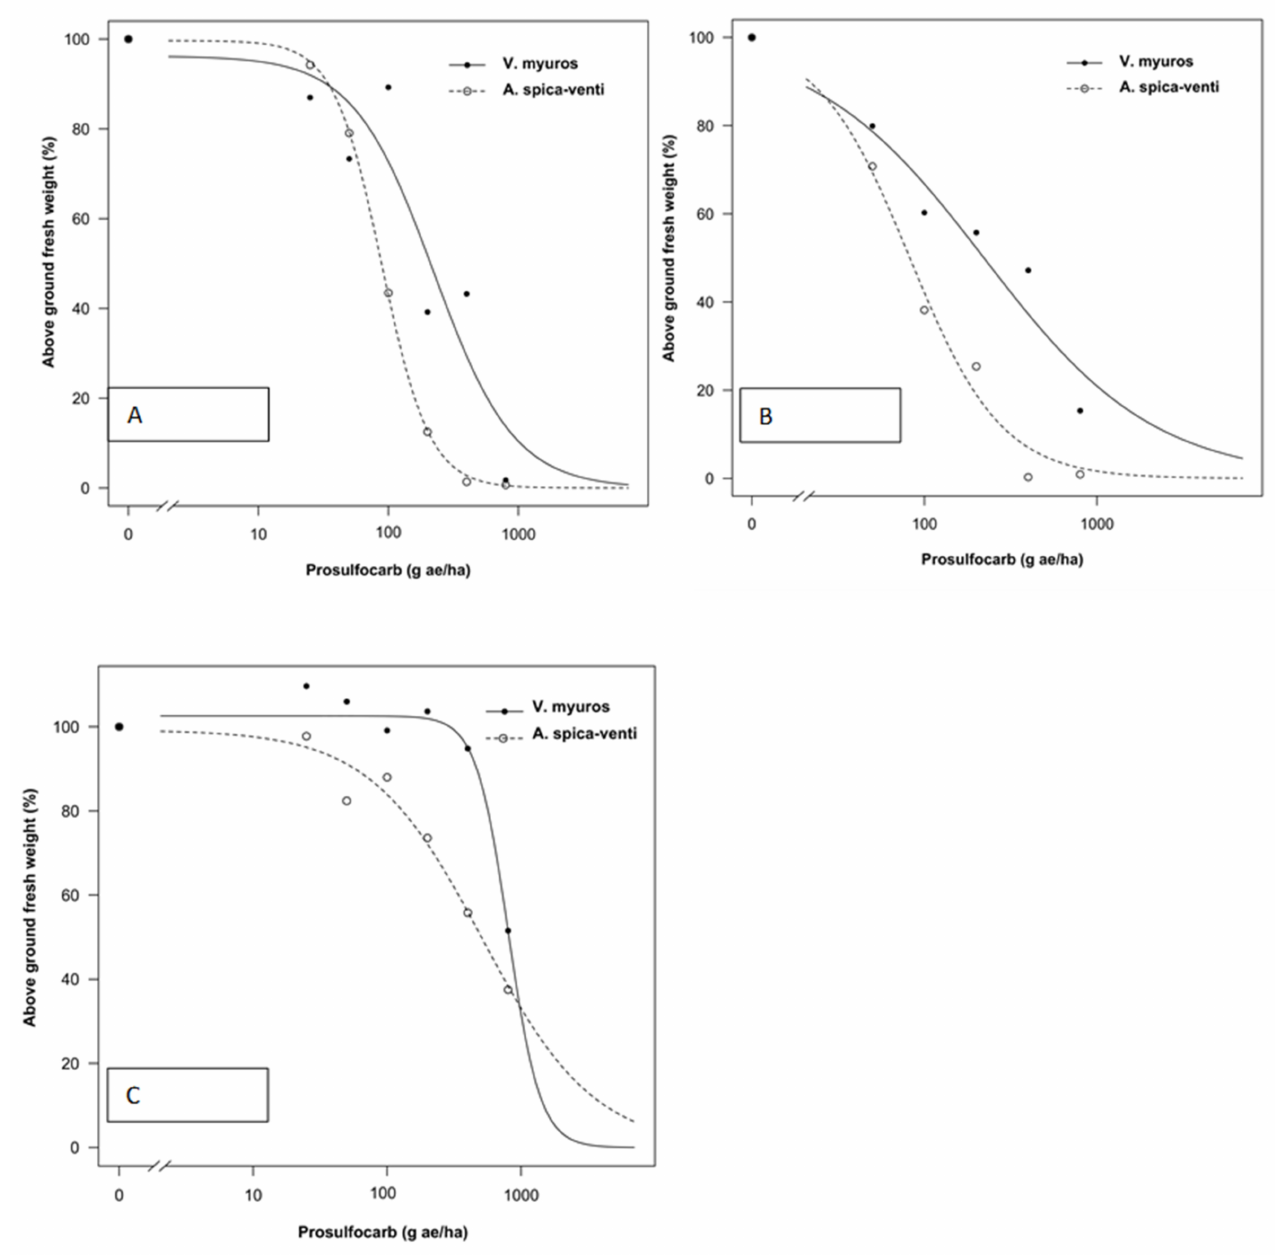
Figure 3. Prosulfocarb dose–response on aboveground fresh weight represented as percentage of untreated control of Vulpia myuros and Apera spica-venti in Experiment 3 at: BBCH 00 ( A ); BBCH 10 ( B ); and BBCH 13 ( C